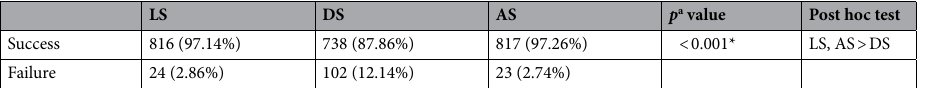
LS DS AS REF p a